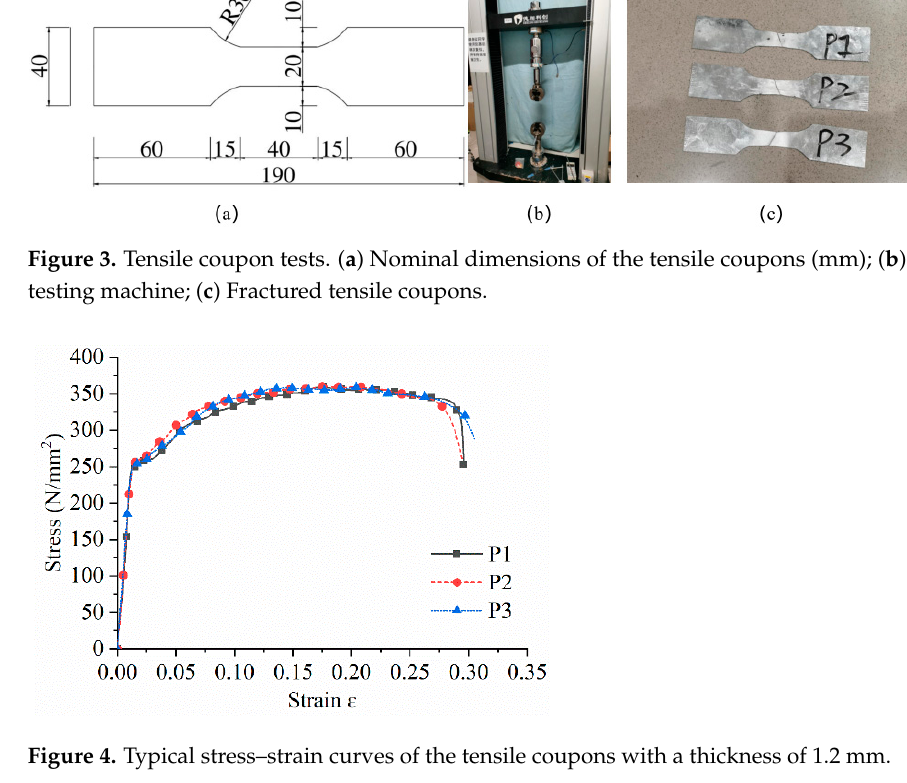
Figure 3. Tensile coupon tests. ( a ) Nominal dimensions of the tensile coupons (mm); ( b ) Universal testing machine; ( c ) Fractured tensile coupons.